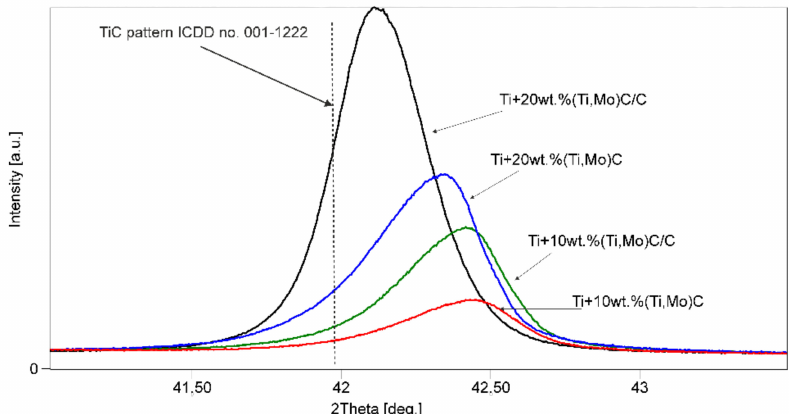
Figure 11. Comparison of the position of interference in reflections (200) of carbides in the TiMMCs.